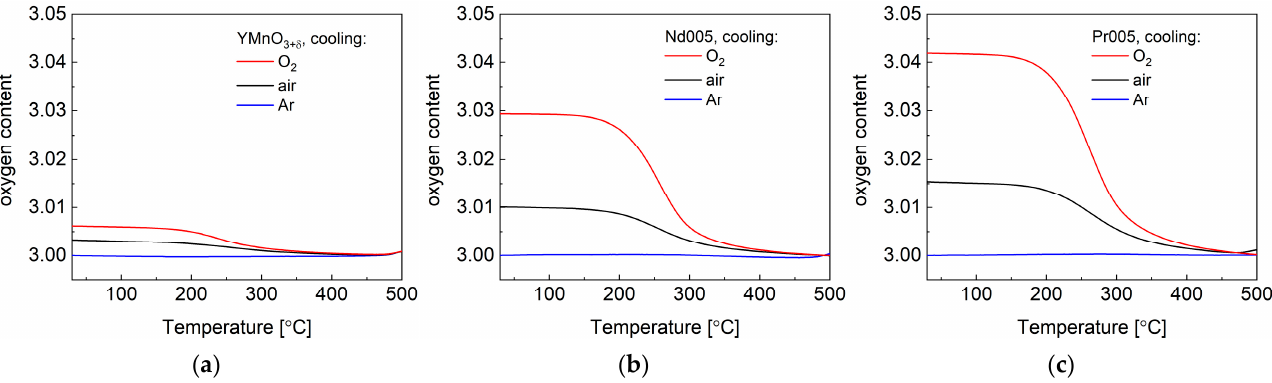
Figure 2. Oxygen content changes in ( a ) YMnO 3+ δ , ( b ) Nd005, and ( c ) Pr005 pellets as a function of temperature in Ar, synthetic air and pure O 2 upon cooling with 2 °C min − 1 rate.